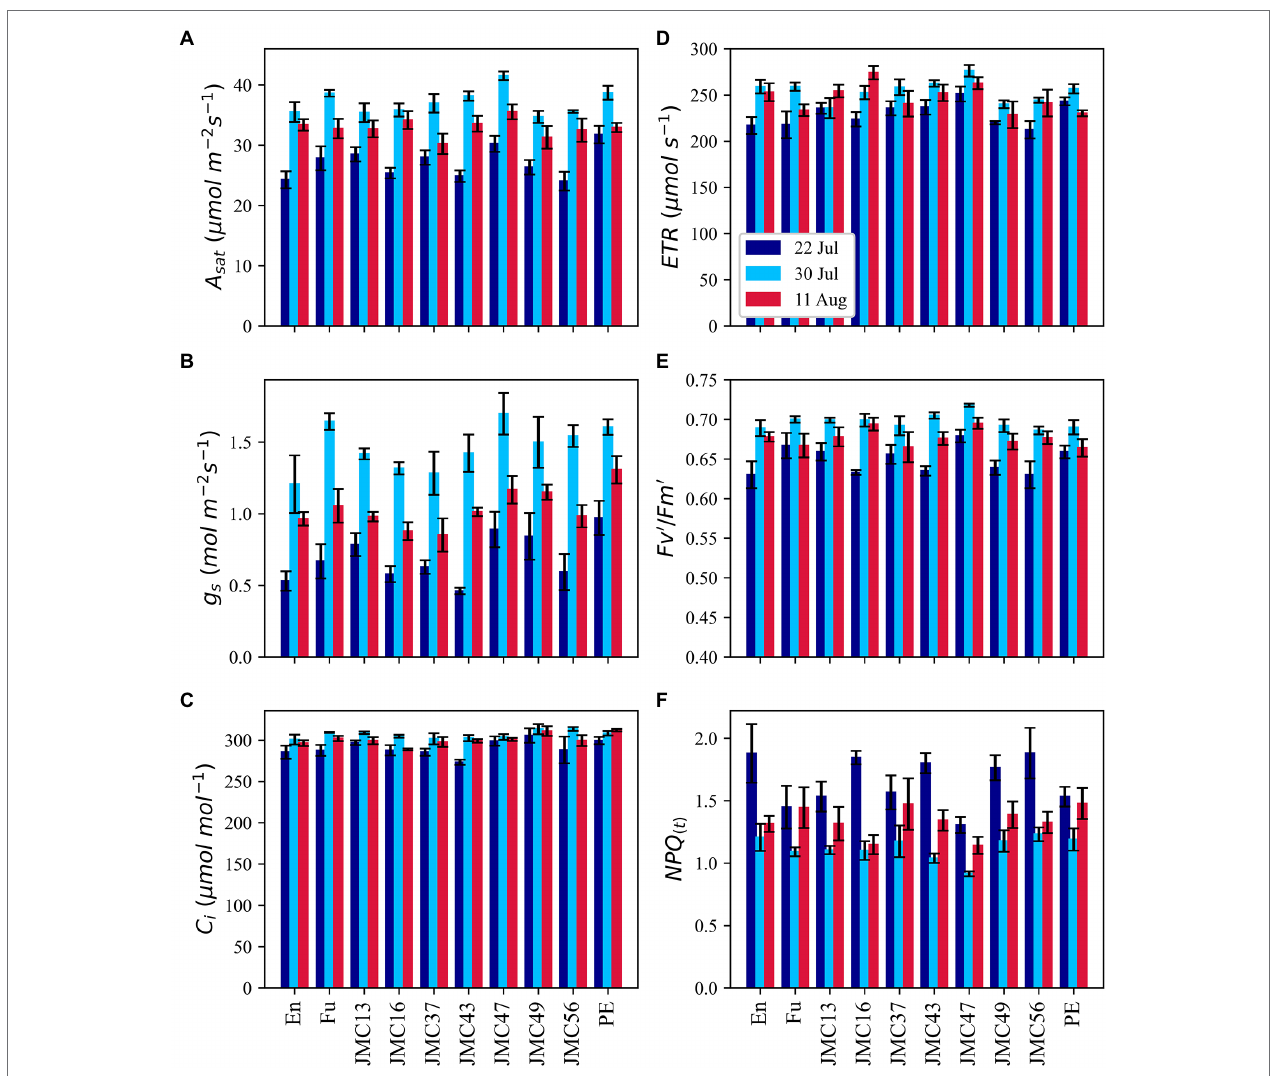
FIGURE 6 | Phenotypic variations in gas exchange and chlorophyll fluorescence parameters; light-saturated photosynthetic rate (A) , stomatal conductance (B) , intercellular